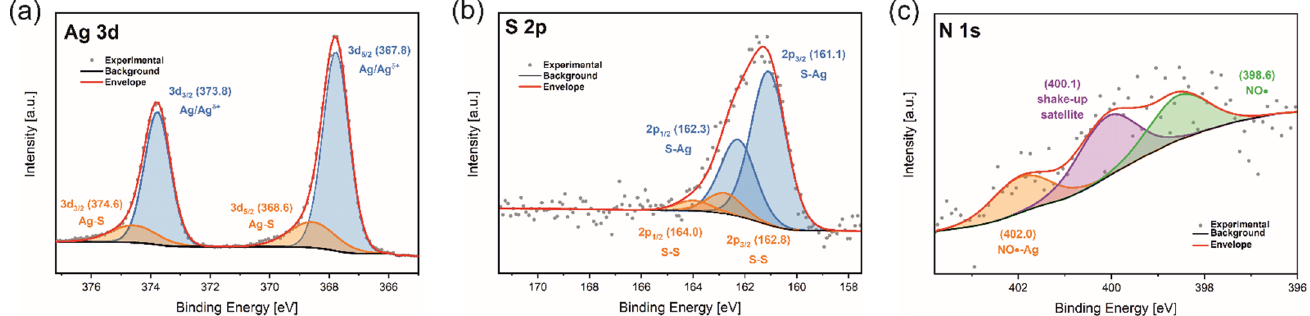
Figure 2. XPS spectra: Ag 3d ( a ), S 2p ( b ) and N 1s ( c ) of N-AgNPs. The values of BDE (eV) are presented in brackets.